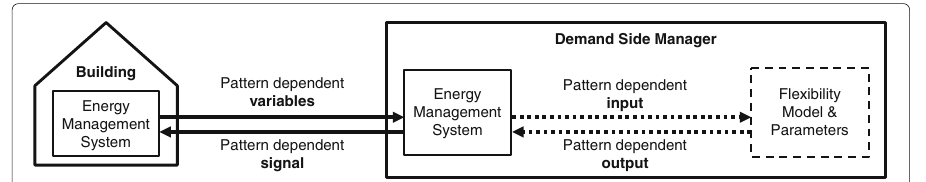
Fig. 2 Based on regularly transmitted variables , e.g. the state of a DER, the demand side manager generates and communicates a signal for influencing the buildings demand. The signal is determined using the models transmitted earlier and the respective patterns (cf. (Förderer et al.